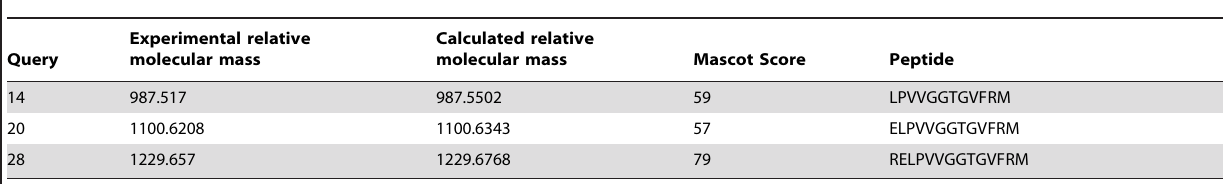
Table 5. Peptide sequence report